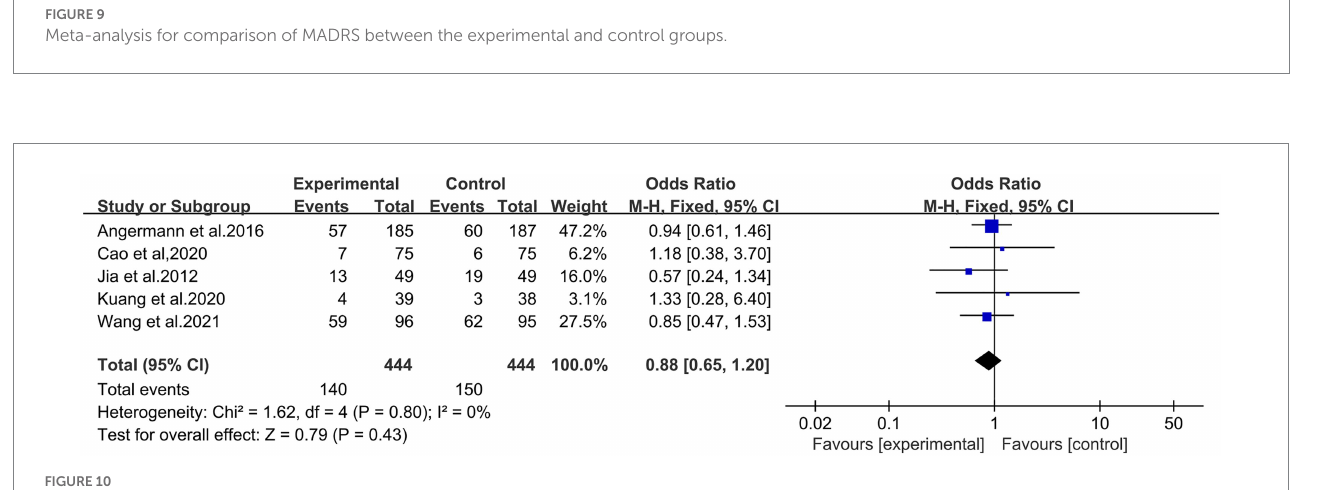
TABLE 2 The GRADE evidence profile for citalopram in the treatment of chronic heart failure combined with depression.